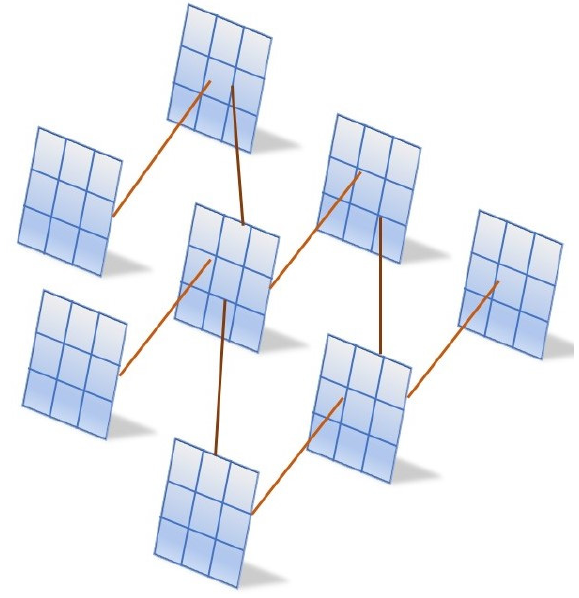
Scheme 4. Schematic representation of bifacial solar panels